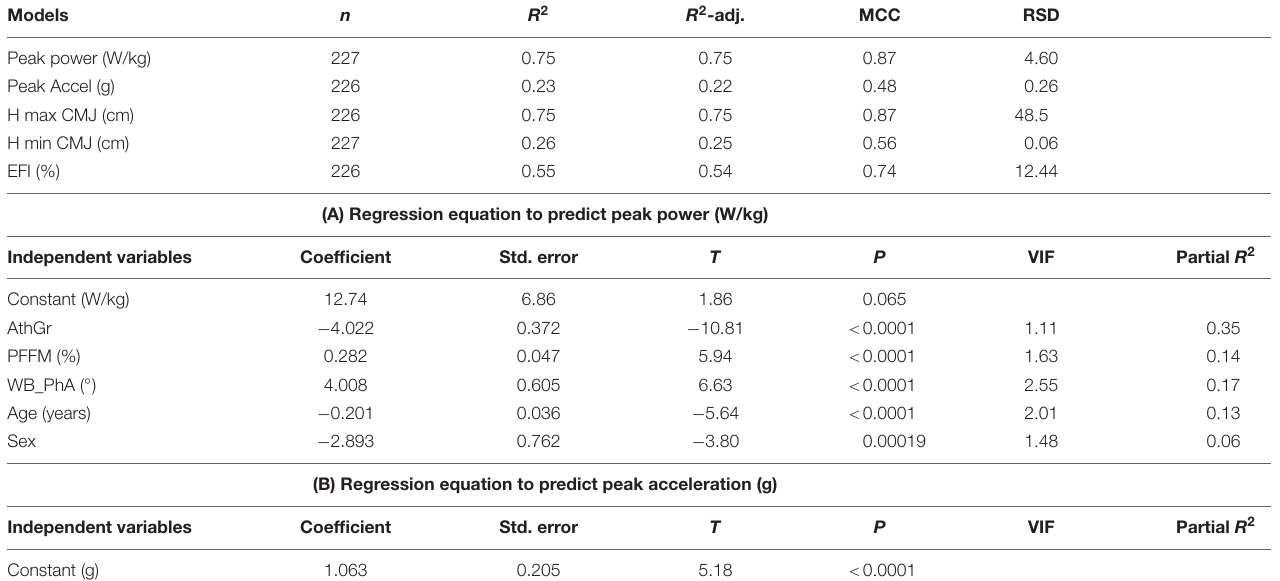
TABLE 6 | Multiple regression analyses to predict independent determinants of vertical jump performance.